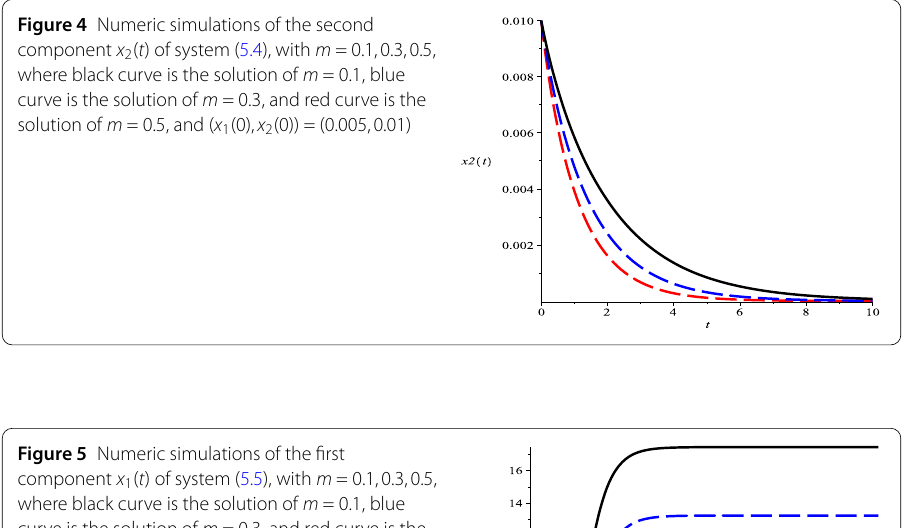
Figure 5 Numeric simulations of the first component x 1 ( t ) of system (5.5), with m = 0.1,0.3,0.5, where black curve is the solution of m = 0.1, blue curve is the solution of m = 0.3, and red curve is the solution of m = 0.5, and ( x 1 (0), x 2 (0)) = (0.005,0.01)